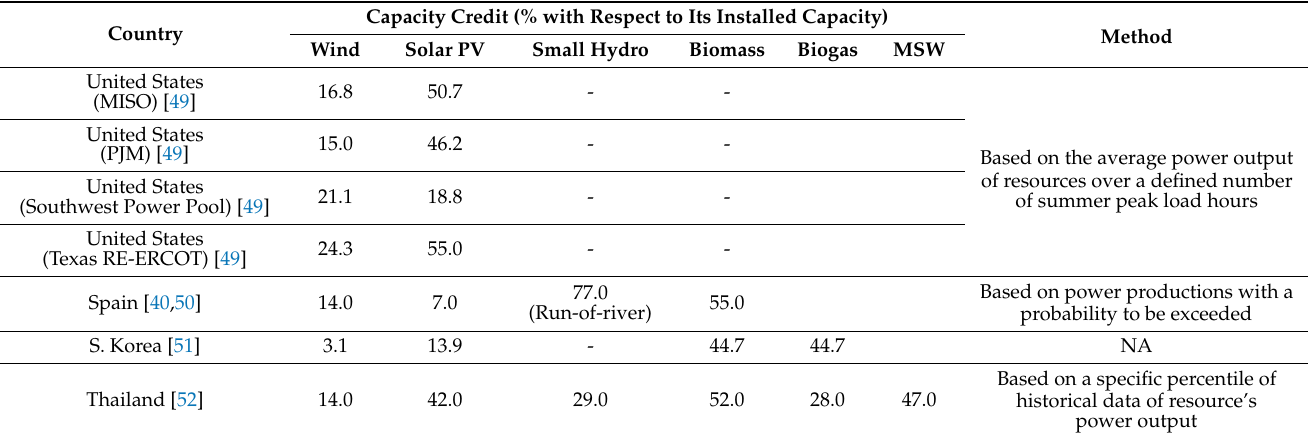
Table 1. Capacity credit of RE resources and its approximation methods adopted by some